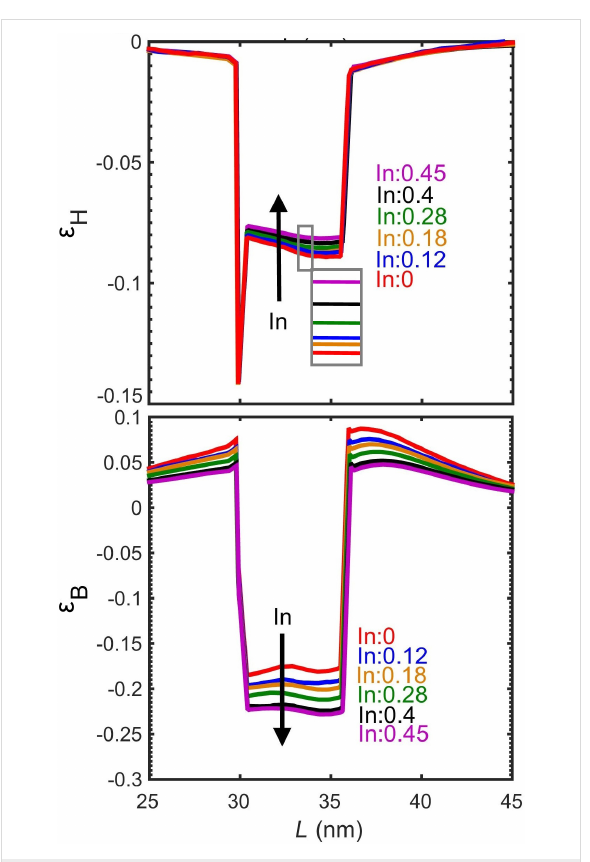
Figure 11: Hydrostatic and biaxial strain with different mole fractions of In along a line passing through the middle of the quantum dot in the [001]